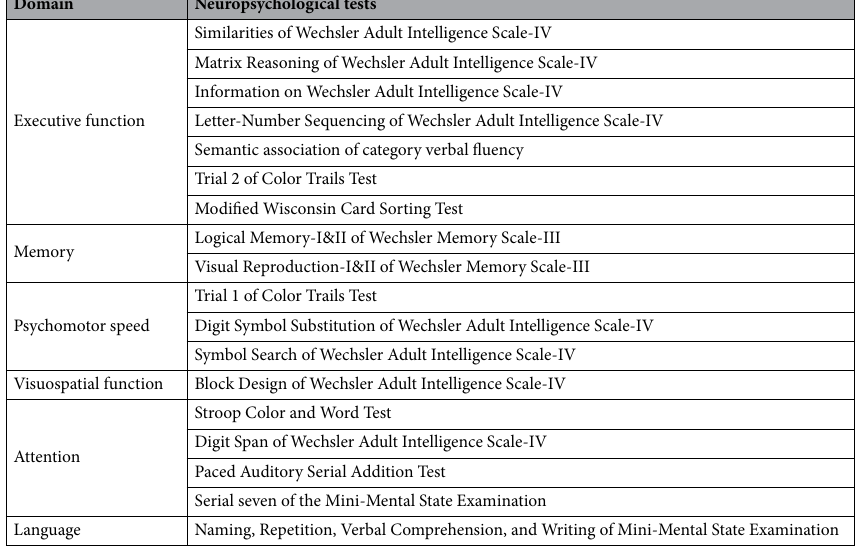
Table 1. Summary of the neuropsychological tests used for the assessment of the major cognitive